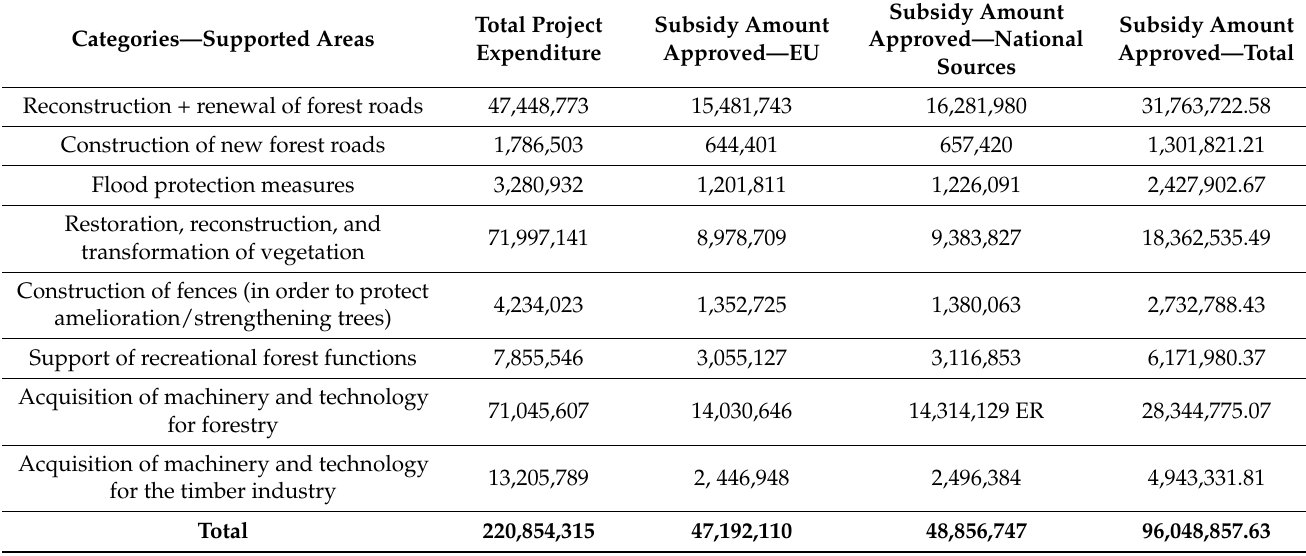
Table 3. Financial support of the selected measures from the RDP CZ 2014–2020 in EUR.